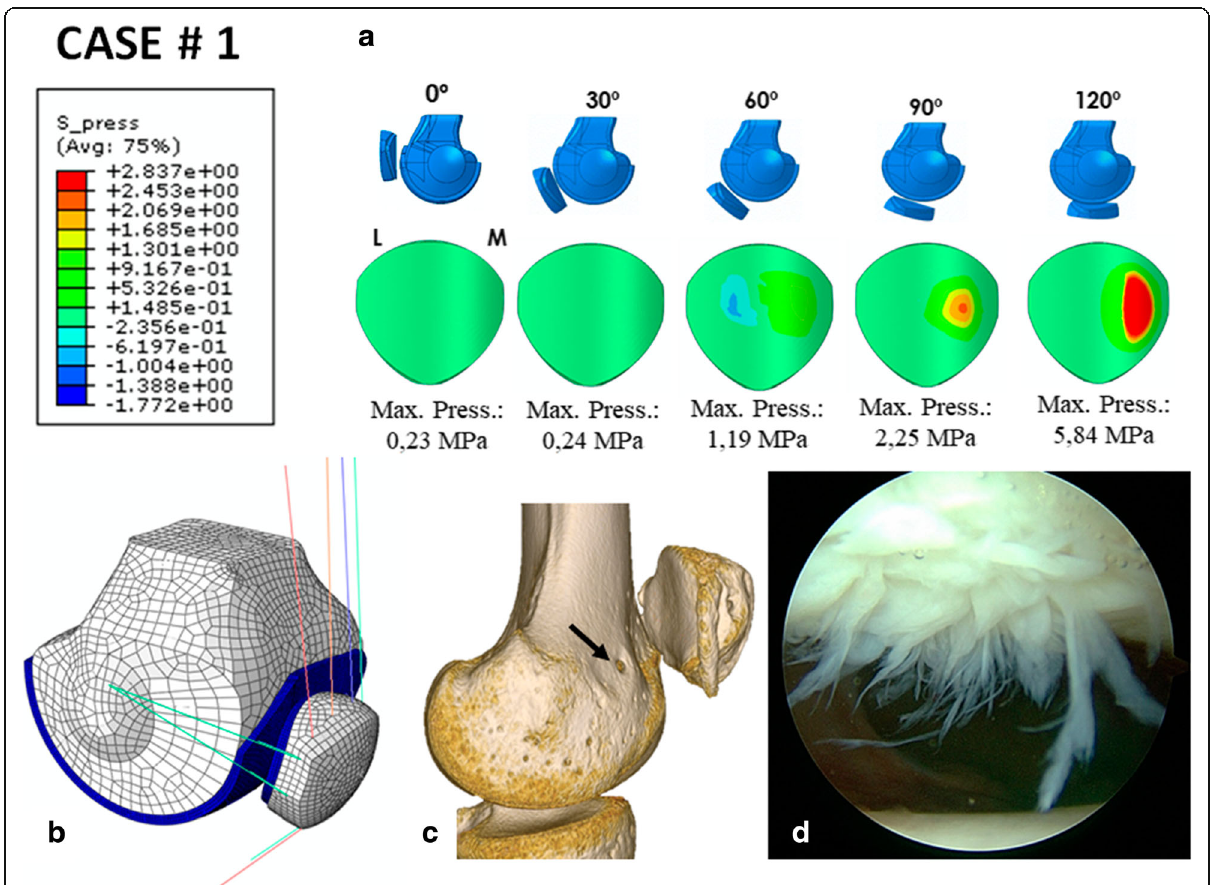
Fig. 4 Case # 1 Surgical failure: a Contact pressure (MPa) on the patellar cartilage L=lateral, M= Medial. b Parametric model of patient # 1. c Femoral attachment point is too far anterior (black arrow). d Visible patellar chondropathy during arthroscopy